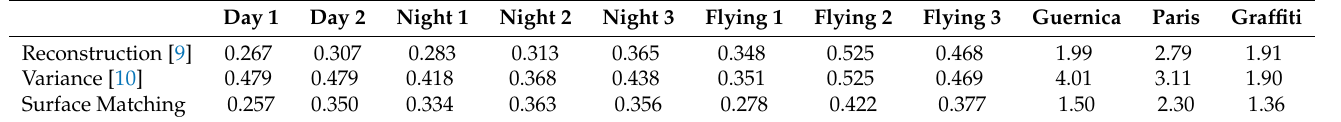
Table 1. Quantitative results of optical flow estimation. The evaluation metric is the AEE (pix/ ∆ t ). Day